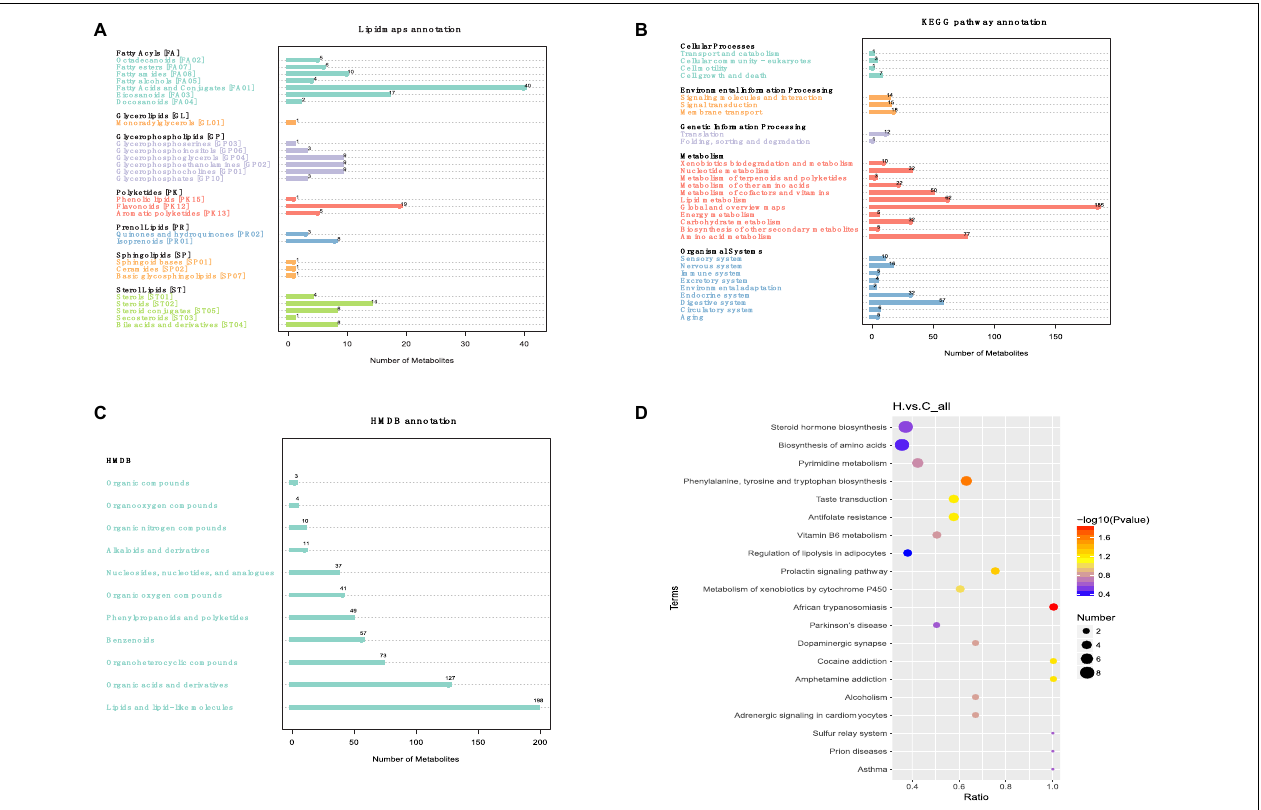
FIGURE 7 | Effects of HS on the metabolic pathway and metabolism of rabbit fecal metabolites. (A) Lipid maps’ classification notes; (B) KEGG access notes; (C) HMDB classification notes; (D) the KEGG Enrichment Bubble Diagram.